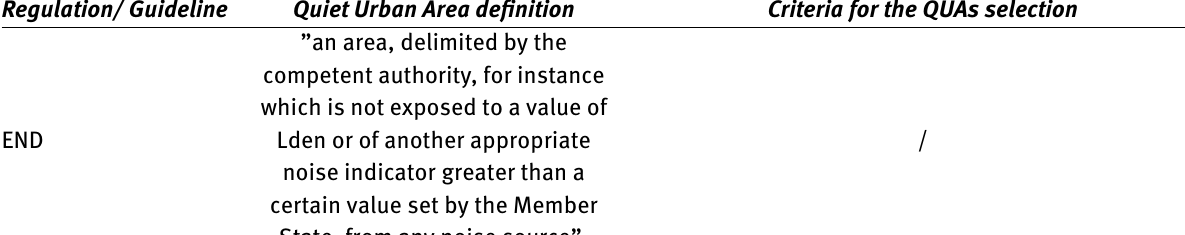
Table 6: Synthesis of QUAs definitions and selection criteria used in Italy and